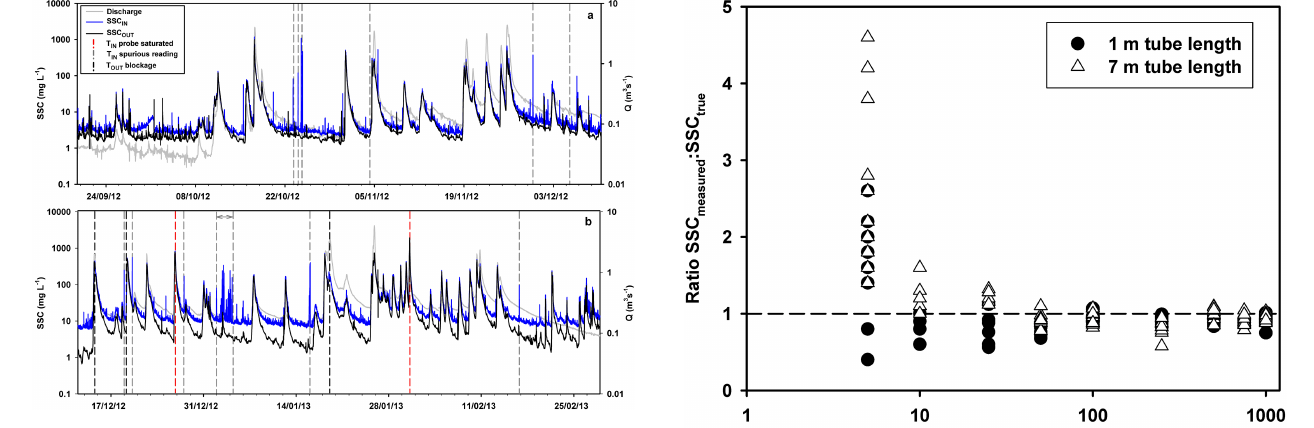
Figure 3. Raw turbidity output of T IN and T OUT sensors (converted to SSC) and discharge at (a) Grassland B and (b) Arable B. Periods of missing data are annotated by dashed lines. Figure 4. Suspended sediment concentration of samples collected from known concentration mixtures (SSC true ) using ISCO water samplers with 1 and 7m tube